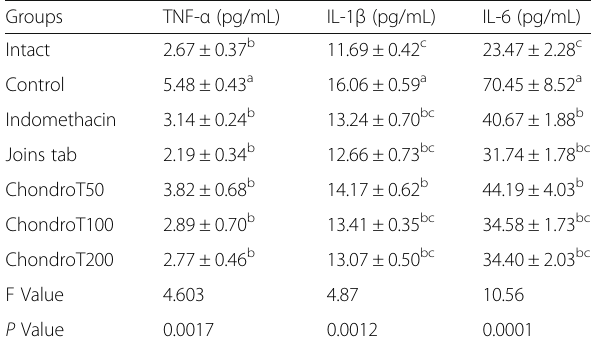
Table 3 Effect of ChondroT on TNF- α , IL-1 β , and IL-6 levels in